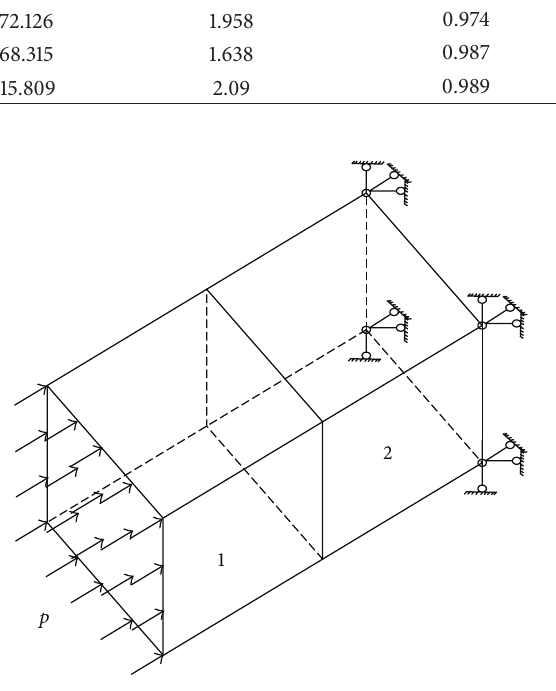
Figure 5: Calculation model of